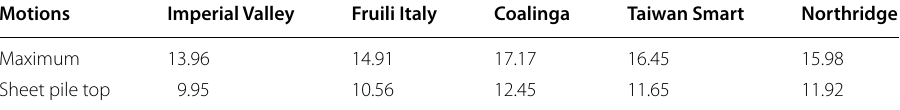
Table 5 Horizontal displacement of the sheet pile under the different earthquake motions (cm) Motions Maximum